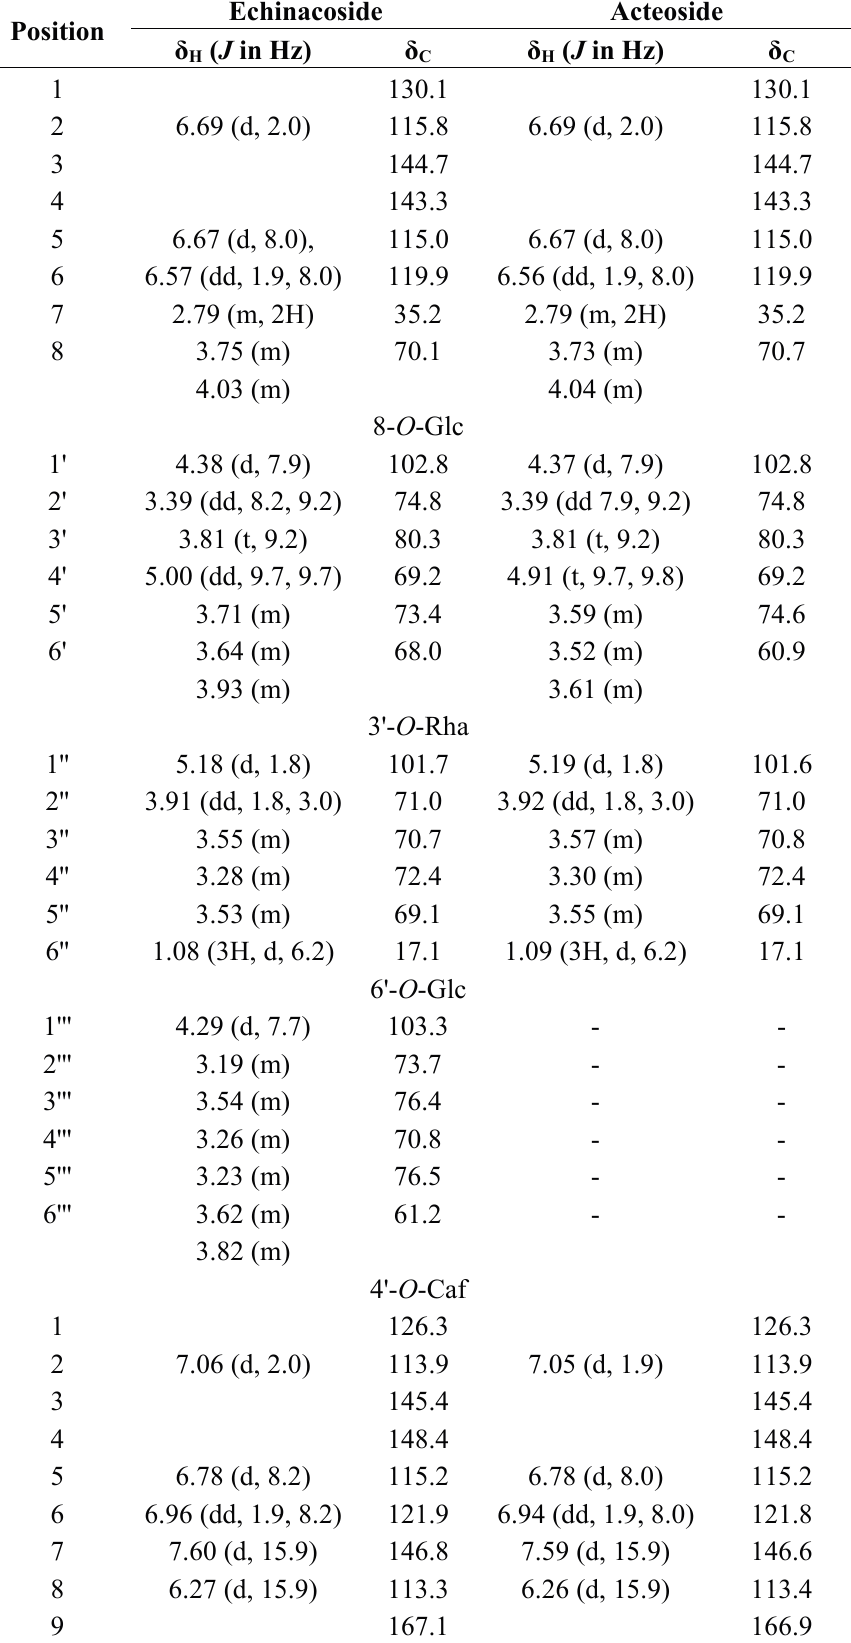
Table 1. 1 H (600 MHz) and 13 C (150 MHz) NMR data of echinacoside ( 1 ) and acteoside ( 2 ) (CD 3 OD, δ in